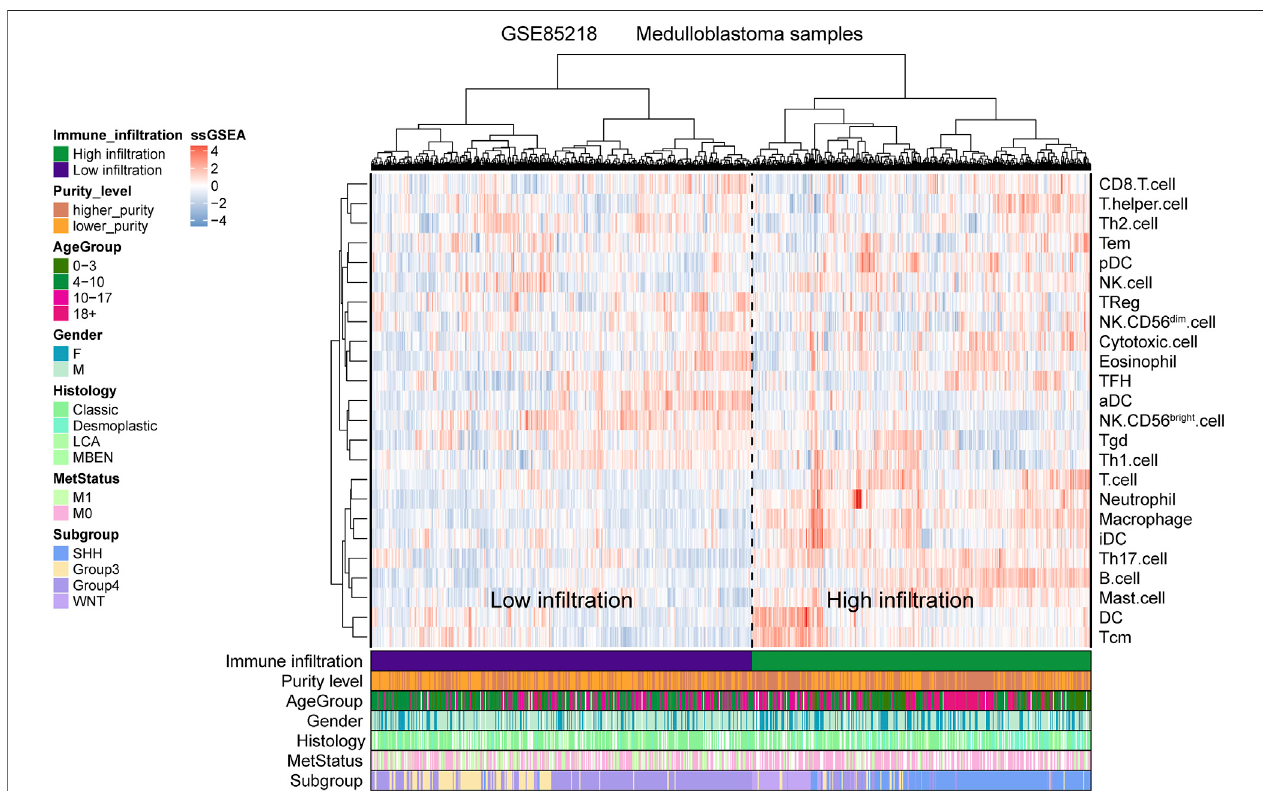
FIGURE 9 | Relationship between the medulloblastoma (MB) purity and the clinical features and immune microenvironment in the GSE85218 dataset as revealed by the single-sample gene set enrichment analysis (ssGSEA).